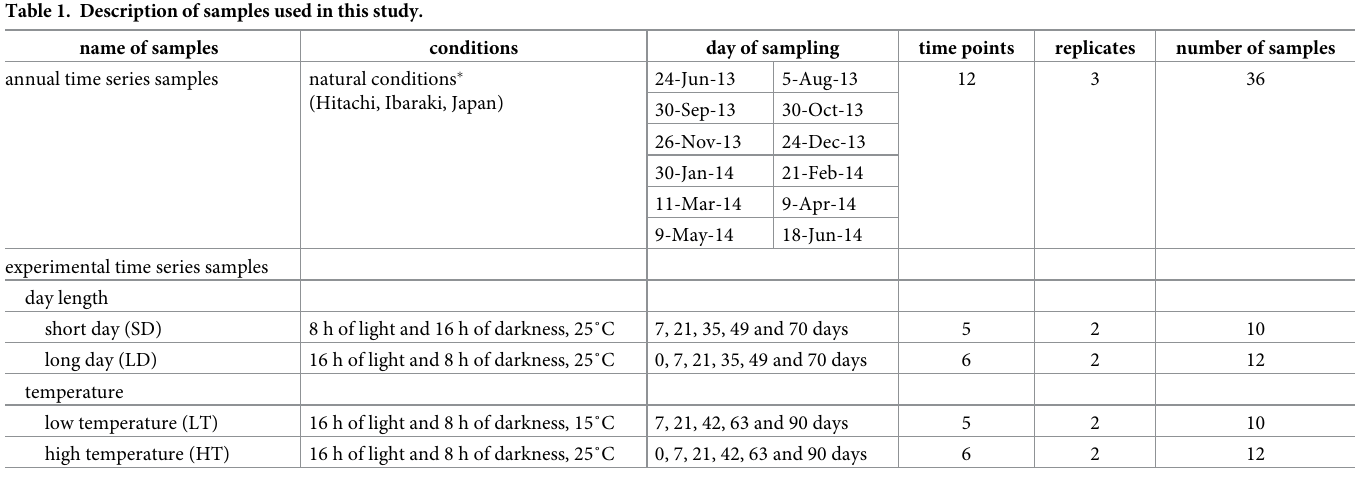
Table 1. Description of samples used in this study. name of